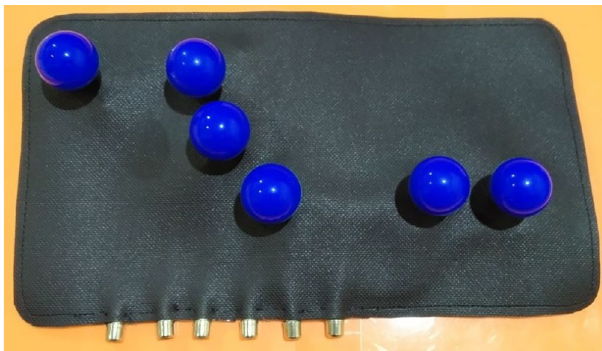
Figure 3. Main view of the ECG SafOne.